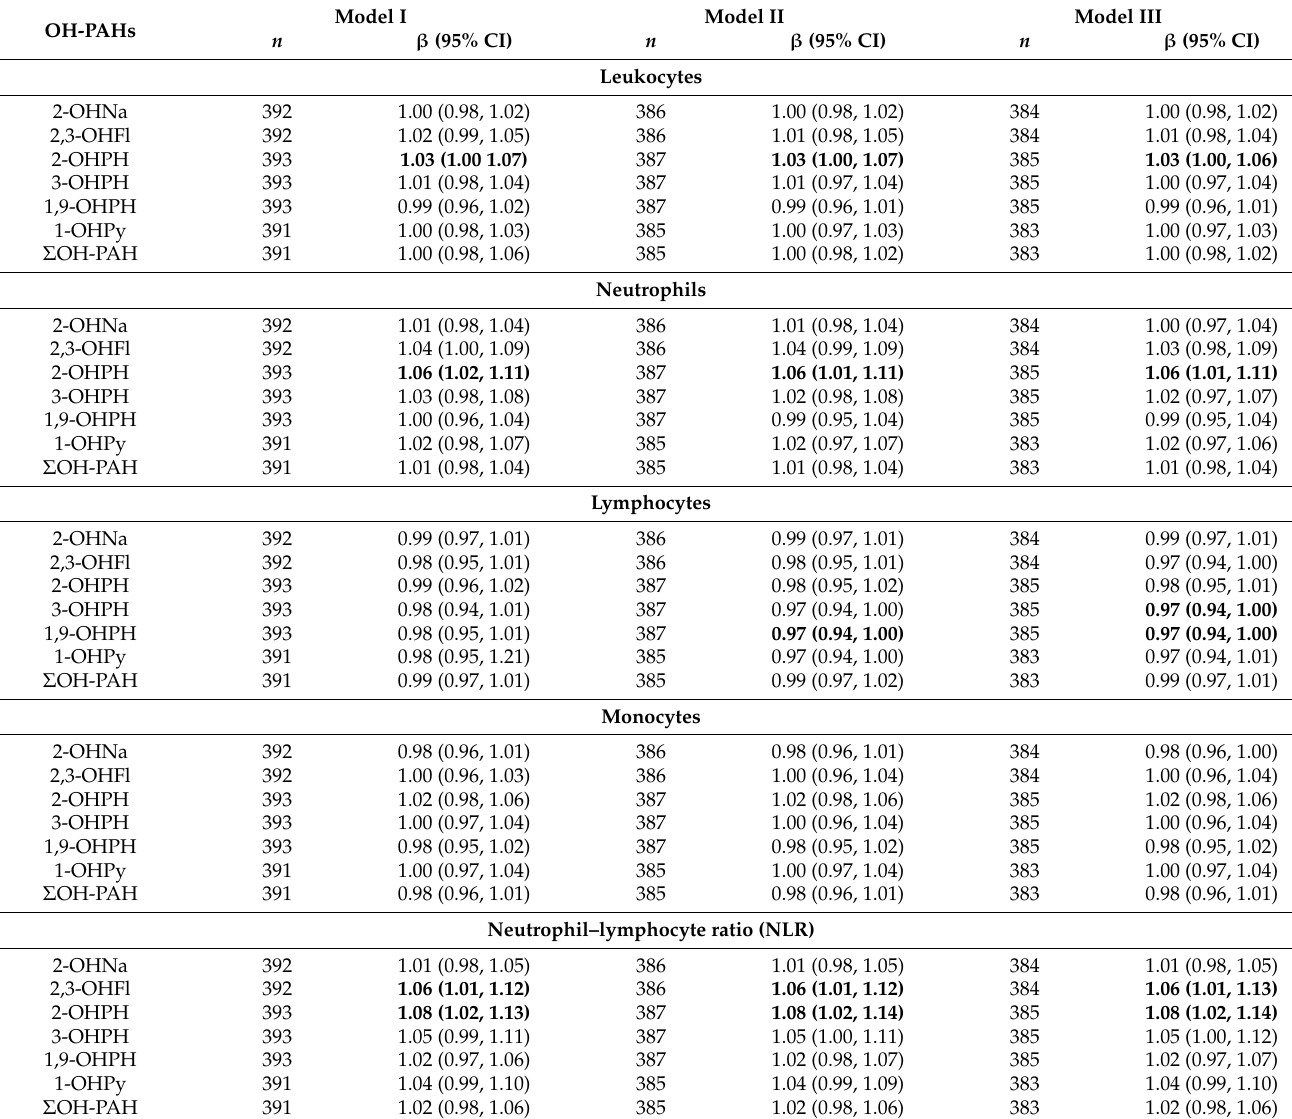
Table 4. Linear regression analyses of urinary OH-PAHs concentrations with leukocyte counts and